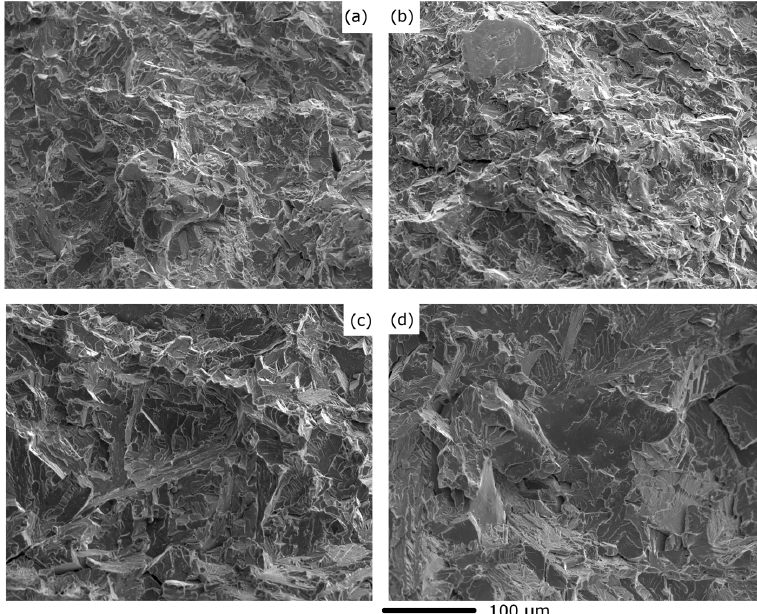
Figure A3. Fracture surfaces of samples after room-temperature fatigue tests, all samples were tested at the same stress. ( a ) HT3 19; ( b ) HT5 19; ( c ) HT3 50; ( d ) HT5 50.